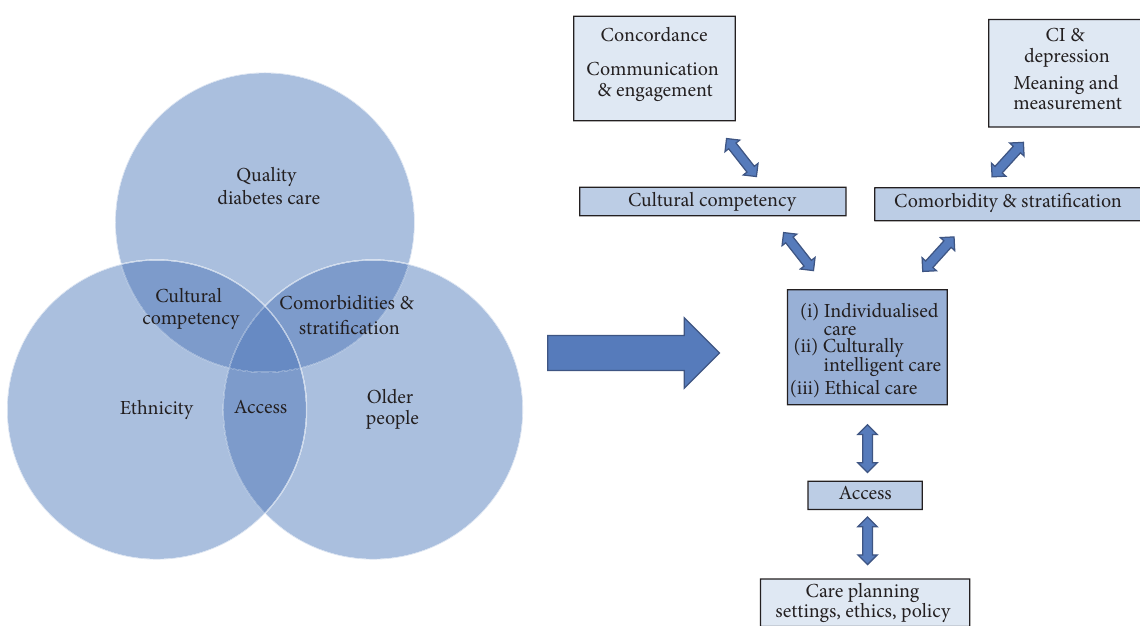
Figure 4: Theory building: concepts and